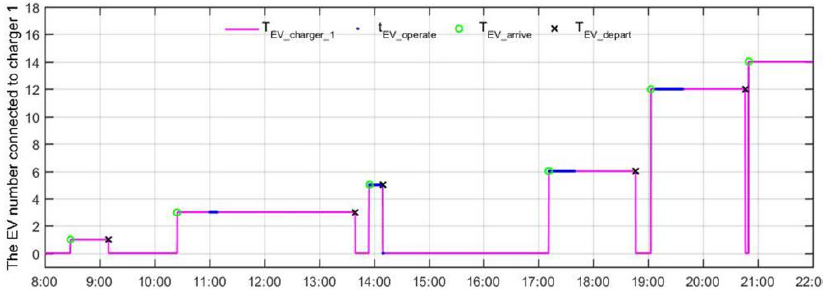
Figure 15. Operating time of EVs connected to charger 1 under ICDA.